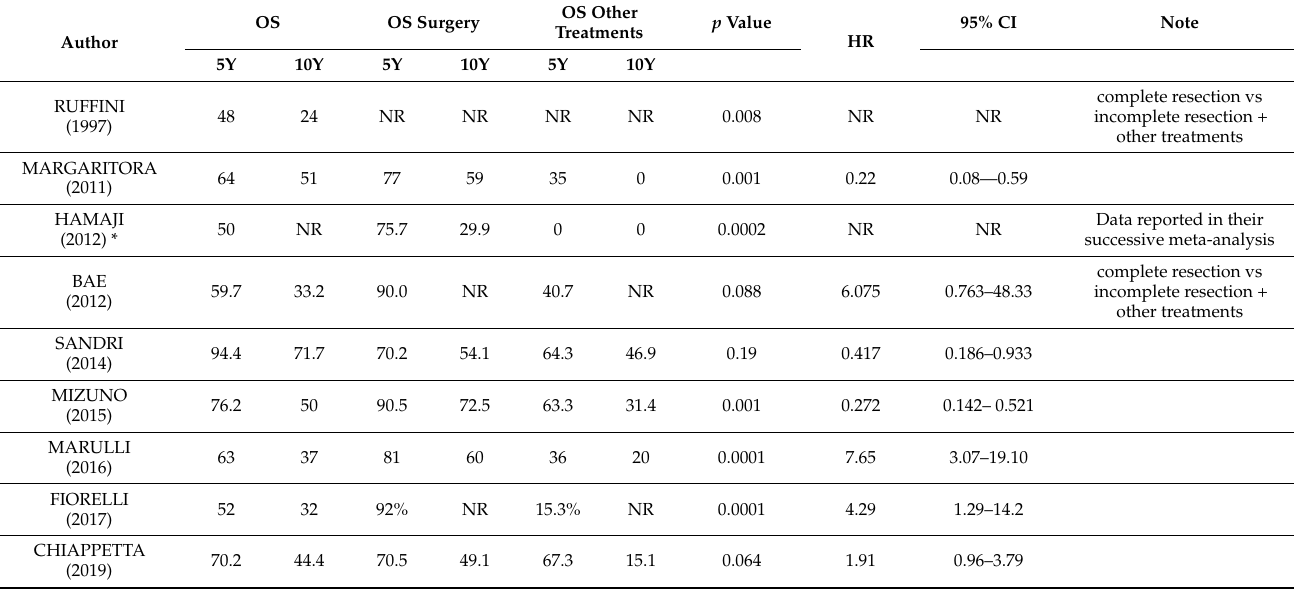
Table 3. Survival outcome reported in different